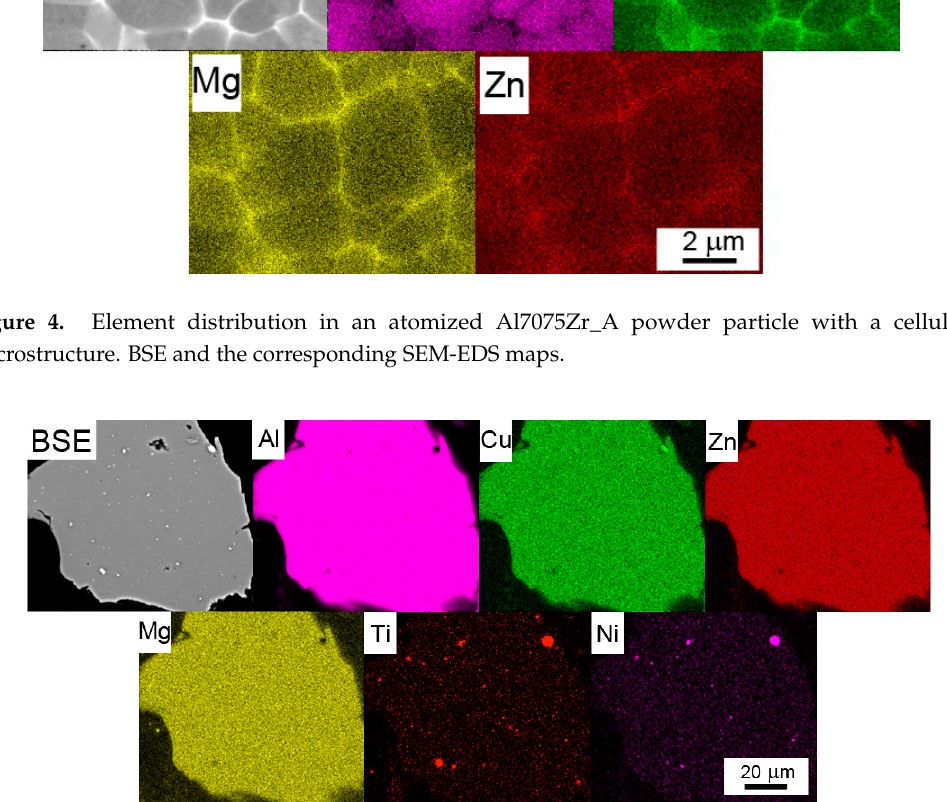
Figure 5. Element distribution in a milled Al7075Zr_M powder particle. BSE and the corresponding SEM-EDS maps.